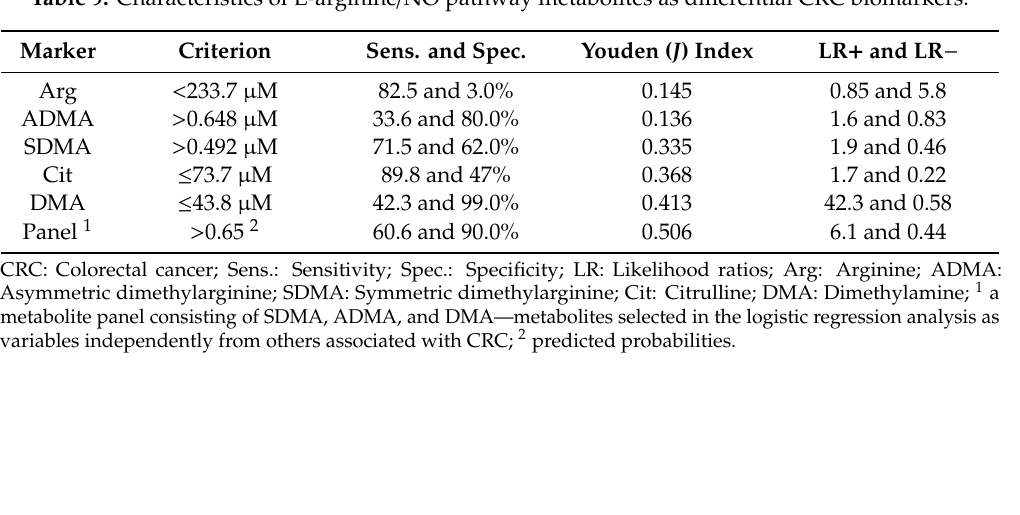
Figure 4. L-arginine / NO pathway metabolites as biomarkers in CRC surveillance in IBD patients: ( a ) Arginine; ( b ) citrulline; ( c ) asymmetric dimethylarginine—ADMA; ( d ) symmetric dimethylarginine—SDMA; ( e ) dimethylamine—DMA; ( f ) metabolite panel consisting of SDMA and ADMA. Data presented as receiver operating characteristic (ROC) curves with a 95% confidence interval ( CI ) and as an area under the ROC curve (AUC) with a 95% ( CI ) and significance of difference from AUC = 0.5, characteristic for a chance marker (represented as diagonal line). The red dot indicates Youden index. Table 8. Characteristics of L-arginine/NO pathway metabolites as biomarkers for CRC surveillance in inflammatory bowel disease (IBD) patients.